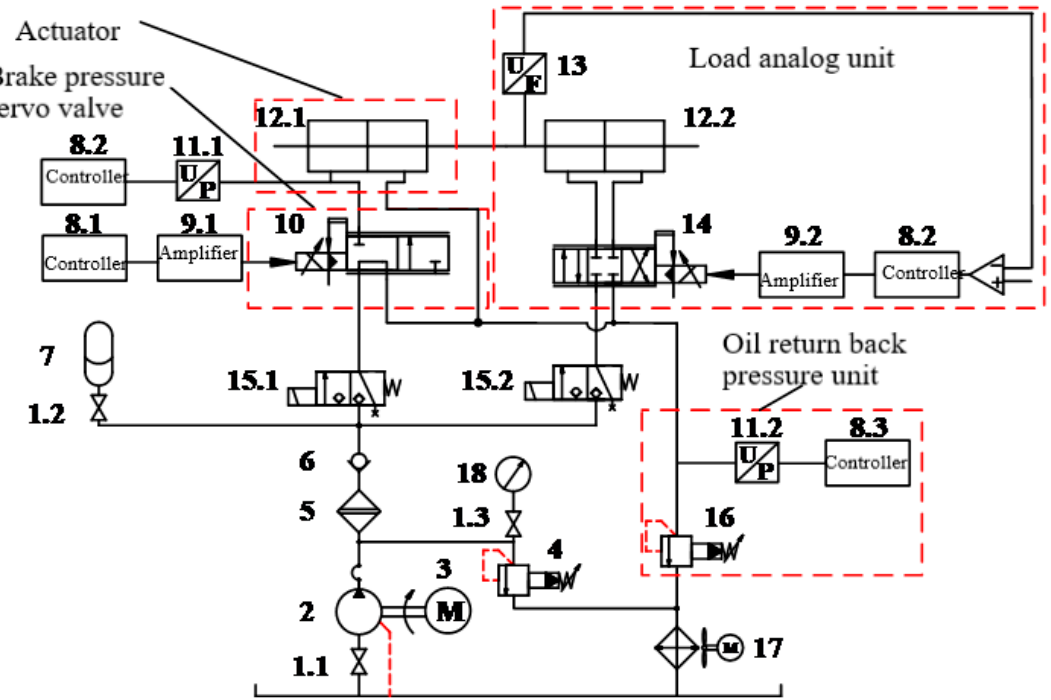
Figure 2. Hydraulic principle of TSBPSV test system. 1—Globe valve; 2—Axial piston quantitative pump; 3—Servo motor; 4—Flood valve; 5—Filter; 6—Check valve; 7—Accumulator; 8—Controller; 9—Amplifier; 10, 14—Servo valve; 11—Pressure sensor; 12—Hydraulic c cylinder; 13—Force sensor; 15—Two position three—way reversing valve; 16—Return oil relief valve; 17—Air cooler; 18—Pressure gauge.